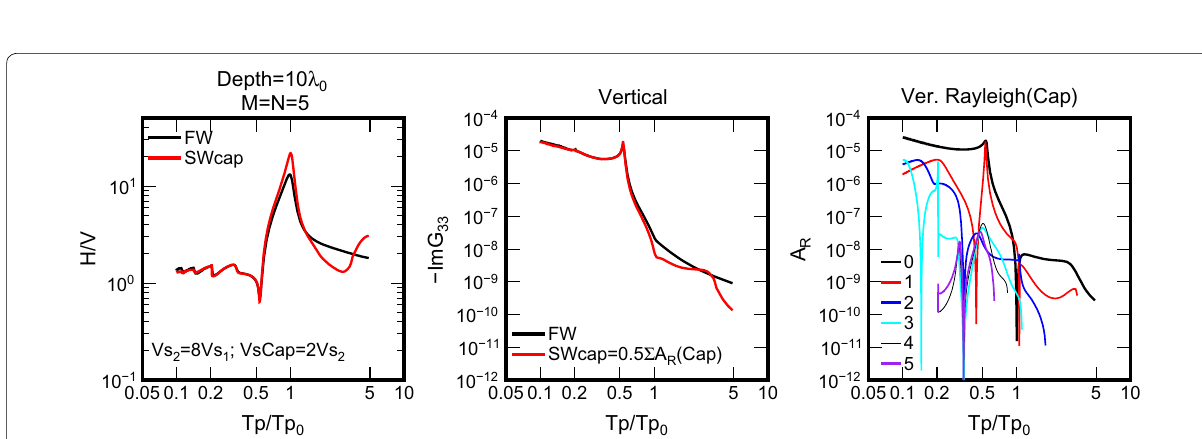
Fig. 4 H / V s, imaginary parts of the Green’s function in the vertical component and vertical medium responses of Rayleigh waves from fundamen‑ tal mode to fifth higher mode. Left: FW H / V (thick black) for target two‑layered medium ( V s2 ( V sCap 2 V s2 , Depth 10 λ 0 ). Middle: imaginary parts of the Green’s function of FW (thick black) in the vertical component for target two‑layered = = medium and that of SW (red) for cap‑layered medium. Right: vertical medium responses of Rayleigh waves for fundamental mode (black), first higher mode (red), second higher mode (blue), third higher mode (cyan), fourth higher mode (thin black), and fifth higher mode